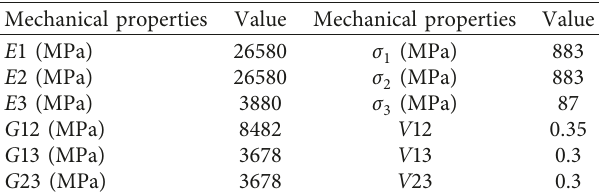
Table 2: Mechanical properties of the CFRP